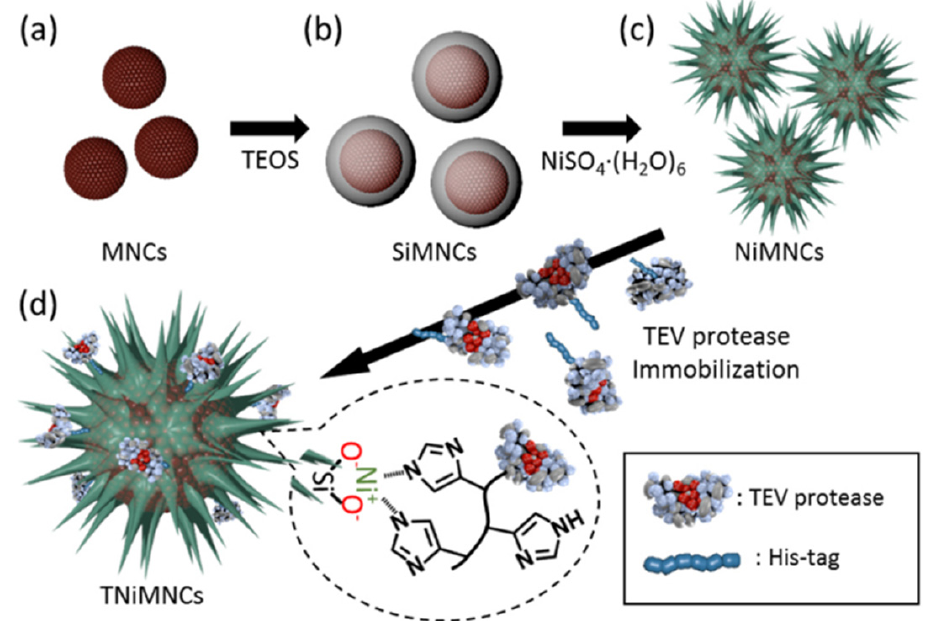
Figure 8. Synthesis of the NiMNCs and TEV protease immobilization. ( a ) Superparamagnetic iron oxide magnetic nanocluster (MNCs) was prepared by thermal decomposition method; Formation of ( b ) silica shell on the surface of MNCs (SiMNCs) (TEOS stands for tetraethoxysilane); ( c ) Silica shell transferred to nickel silicate (NiMNCs); and ( d ) His-tagged TEV protease immobilized on the surface of NiMNCs (TNiMNCs). Reproduced with permission from [59], IOP Publishing, 2016. The other objective of the surface modification deals with tuning the hydrophobicity– hydrophilicity balance for better compatibility of the enzyme, support, and the sub- strate [73,76,77,83,85,86]. Lipase is a typical enzyme requiring surface modification due to its high affinity to hydrophobic molecules. In some cases, an enzyme (not a support) is modified, as has been reported for porcine pancreas lipase (PPL) [76]. PPL was func- tionalized with dodecyl aldehyde and combined with a magnetic support, resulting in the enzyme immobilization loading of about 100% and the biocatalyst efficiency of ~80%. In a reverse strategy, magnetic NPs coated with polymers containing long alkyl chains (octyl or hexadecyl) have been utilized for immobilization of Candida rugosa lipase (CRL) [82]. Hexadecyl tails allowed for higher loading of the enzyme and its binding in the open conformation, promoting enzyme performance. On the other hand, very hydrophobic multiwall carbon nanotubes containing magnetic Co NPs required an additional functional- ization with aminated polydopamine for immobilization of CRL via a covalent attachment with glutaraldehyde [75]. This biocatalyst displayed high efficiency, stability in a wide pH and temperature range, and enhanced reusability. Here, mere hydrophobicity without functionality was not sufficient for CRL immobilization. Functional ionic liquids have been reported as modifying agents for lipase immobiliza- tion on a magnetic support [85,86]. The authors coated magnetite NPs with chitosan (CS), at- tached an imidazole-containing ionic liquid (IL), and then immobilized PPL (Figure 9) [85]. The enhanced immobilization degree, biocatalyst efficiency, as well as higher tolerance to pH and temperature changes were assigned to improved biocompatibility due to CS and the effect of the IL ion, protecting the PPL native